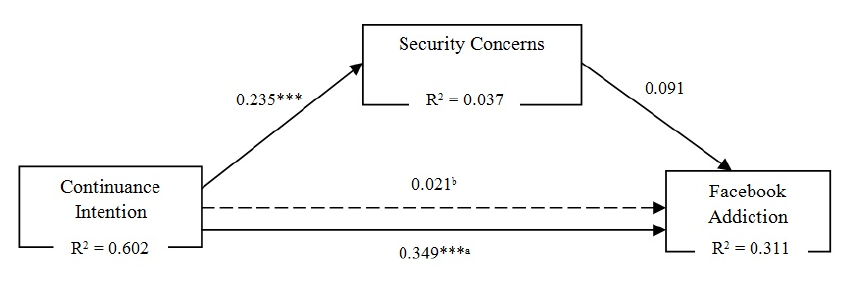
Fig. 2. Continuance intention–security concerns-Facebook